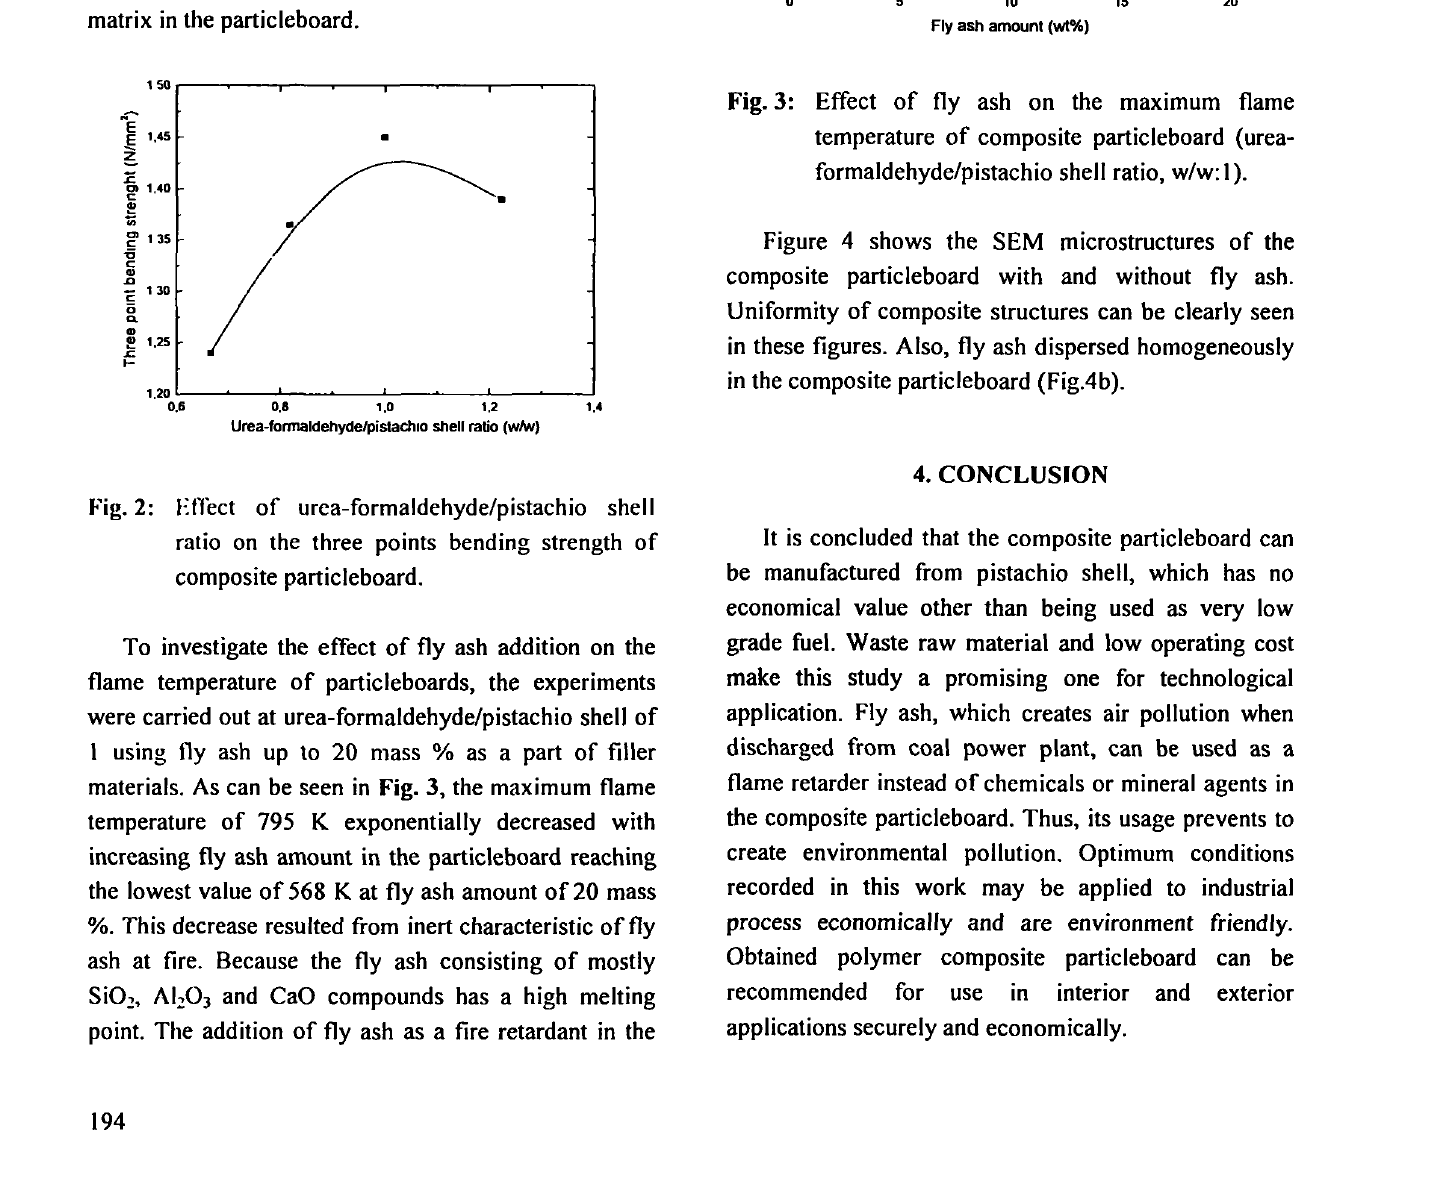
Fig. 3: Effect of fly ash on the maximum flame temperature of composite particleboard (urea- formaldehyde/pistachio shell ratio,